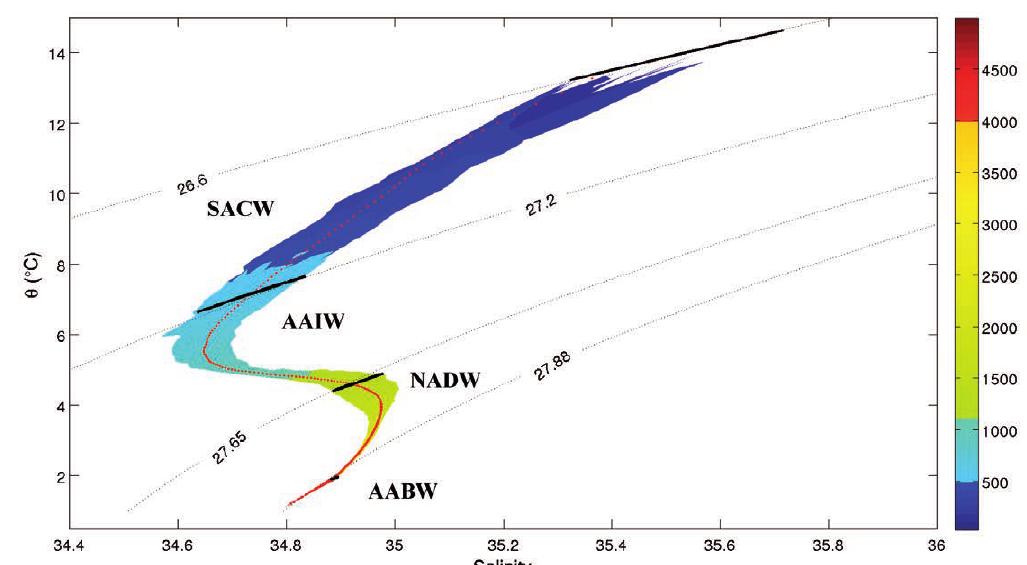
f ig . 3. – Potential temperature-salinity diagram, colour-coded for depth, as produced with data from the 2010 transect; a reference profile (dotted curve) is calculated as a zonal average for the different depth levels. The black dotted lines show several selected isopycnals ( s 27.2, 27.65, 27.88) and the black curves correspond to isoneutrals separating the water masses ( g n =26.65, 27.3, 27.8 and 28.12). Waters lighter than g n =26.65 are excluded from this representation. A colour version of this figure may be found in the online electronic